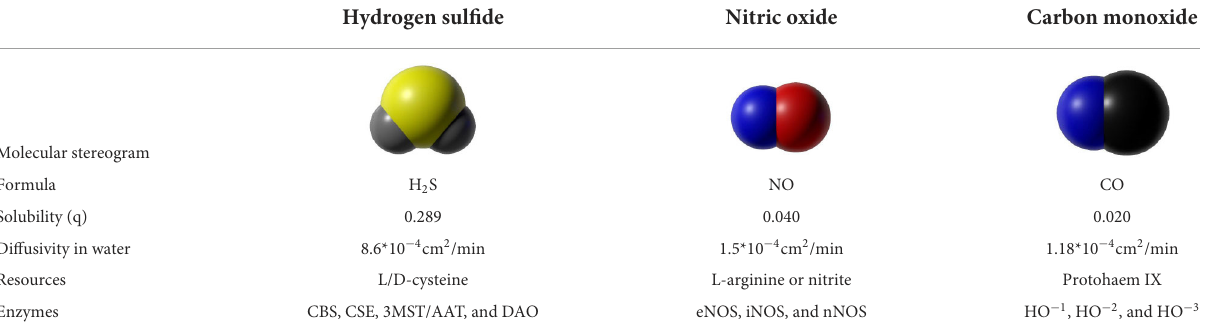
TABLE 1 Comparison of common characteristics of the three gas